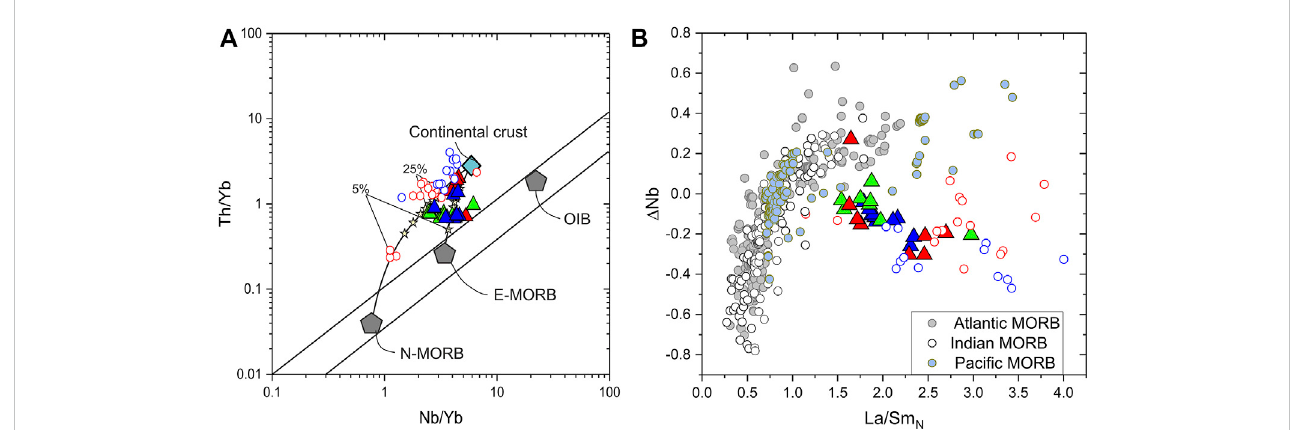
FIGURE 8 The Th/Yb versus Nb/Yb variations of the Ghatgaon, Keonjhar and Pipilia dyke swarm. The oceanic mantle array is from Pearce (2008). The average compositions of oceanic mantle end members include depleted mid-ocean ridge basalt or normal mid-ocean ridge basalt (N-MORB), enriched mid-ocean ridgebasalt(E-MORB)andoceanislandbasalt(OIB)(SunandMcDonough, 1989).TheaveragecontinentalcrustvaluesarefromRudnickandGao(2014).Two lines with solid yellow stars illustrate 5% – 25% mixing lines of continental crust with N-MORB and E-MORB. (B) The Δ Nb versus La/Sm N (normalized to primitivemantle;SunandMcDonough1989).TheSinghbhumdykesexhibitLa/Sm N > 1,whichareconsistentwithLREEenrichednature(Fitton,2007),andare compositionally distinct from midoceanic ridge basalts (MORB). The data of Atlantic, Paci fi c and Indian MORB are from Arevalo Jr and McDonough